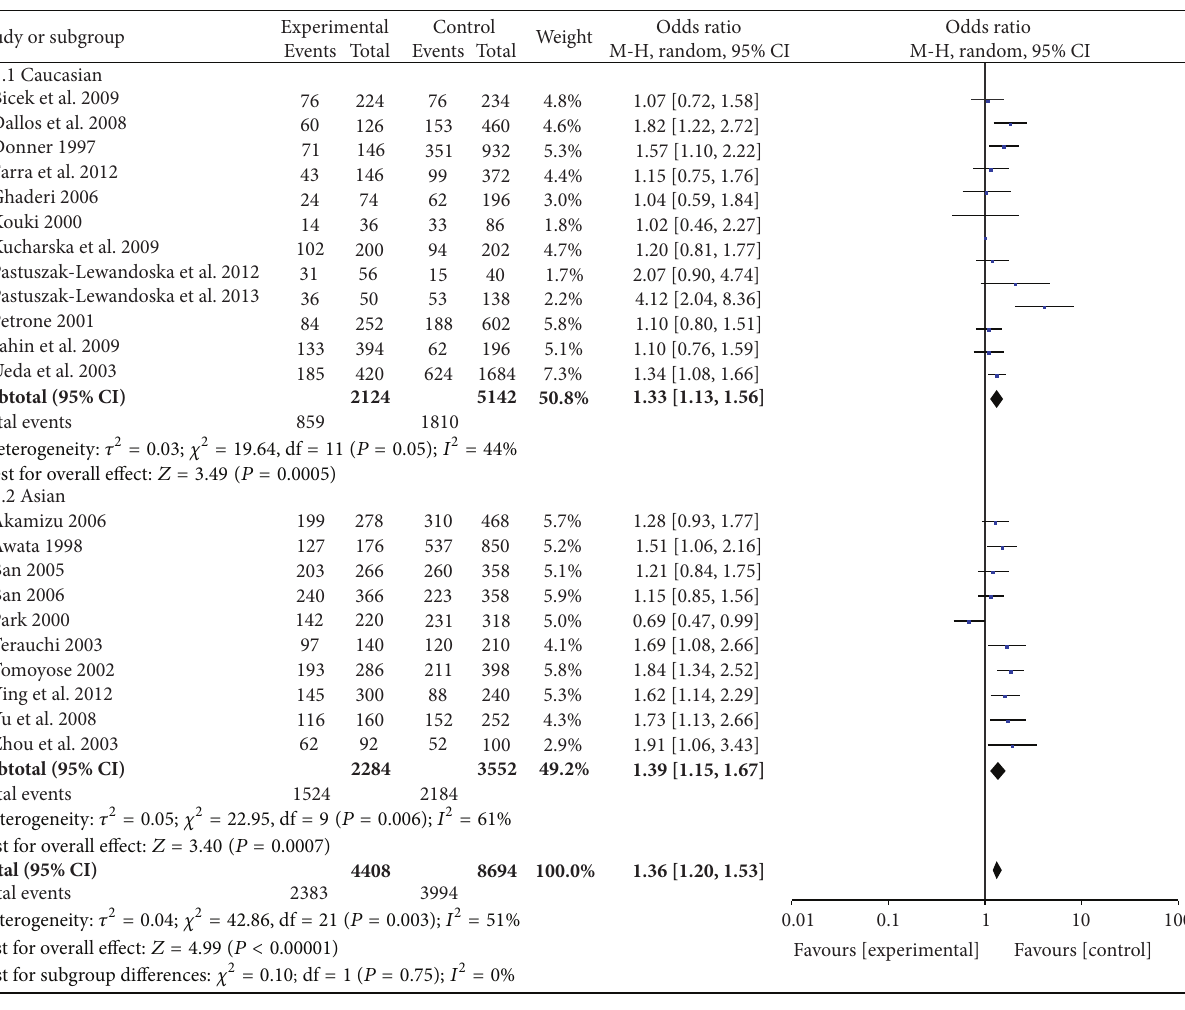
Figure 3: Forest plot of the association between an allele model of A49G polymorphism and